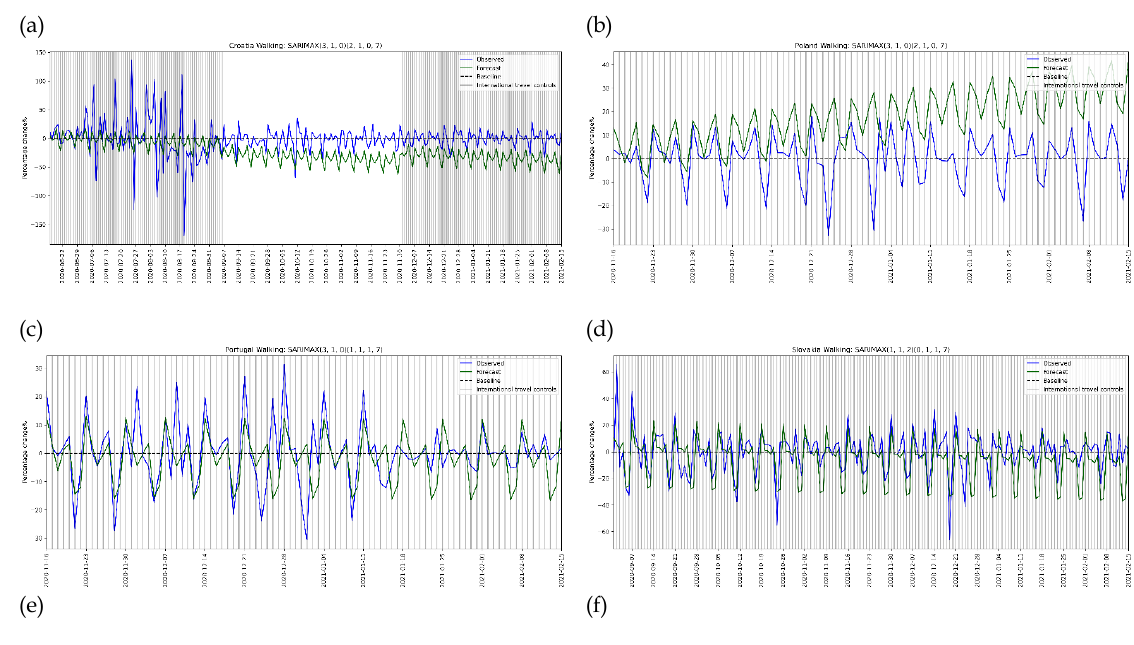
Figure 11. SARIMAX forecasts for driving in relation to International travel controls (a: Austria, b: Belgium, c: Hungary, d: Italy, e: Latvia, f: